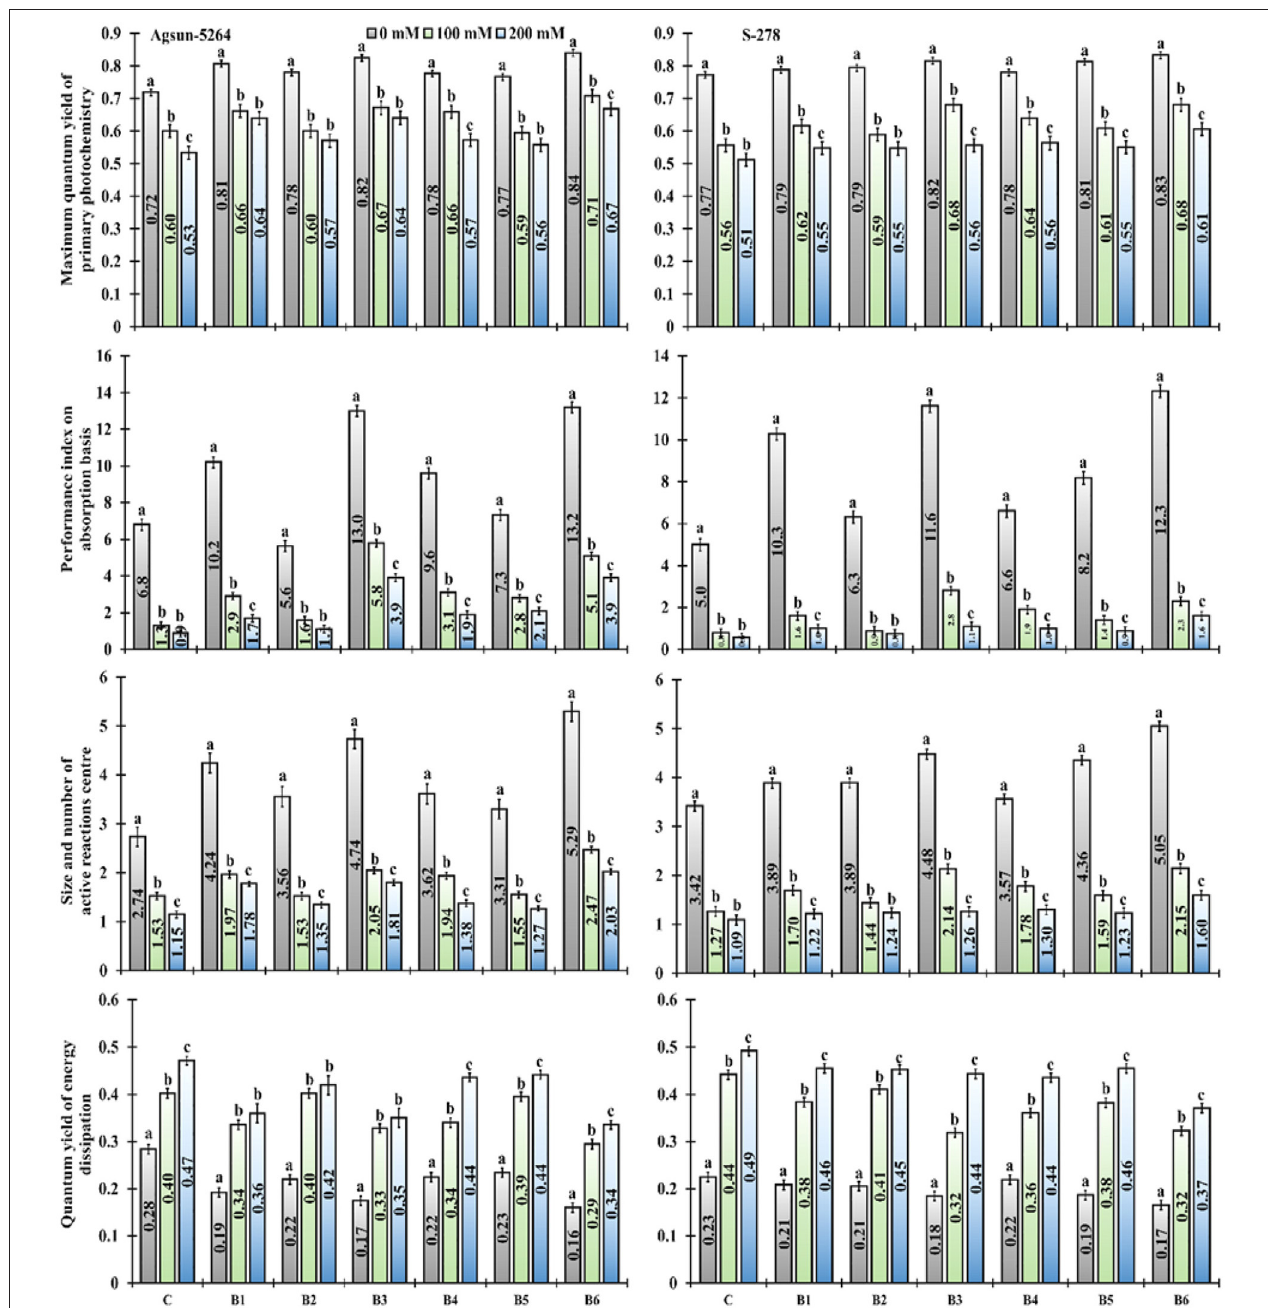
FIGURE 3 | Effect of halophilic microbial strains on Maximum quantum yield of primary photochemistry (F V /F M ), Performance index on absorption basis (PI ABS ), Size and number of active reaction center (F V /F O ) and Quantum yield of energy dissipation (F O /F M ) of sunflower cultivars during salinity stress. Vertical line on the bar represents mean standard error (S.E). Similar alphabet shows non-significant difference at p ≤ 0.05 ( Bonferroni post-hoc test ) between